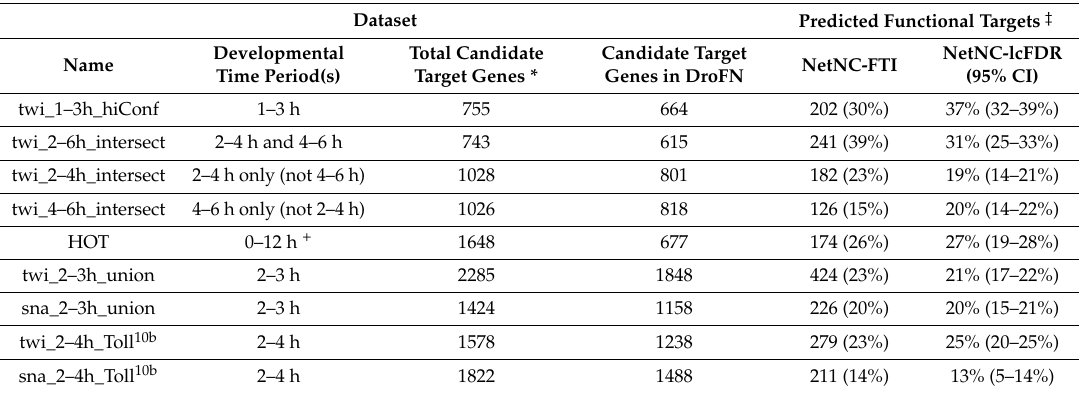
Table 1. Predicted functional binding for Snail, Twist and Highly Occupied Target (HOT) candidate target genes. The developmental time periods correspond to the following developmental stages: 2–4 h stages 4–9 (except 2–4 h_intersect datasets which were stages 5–7 [53]); 2–3 h stages 4–6; 1–3 h